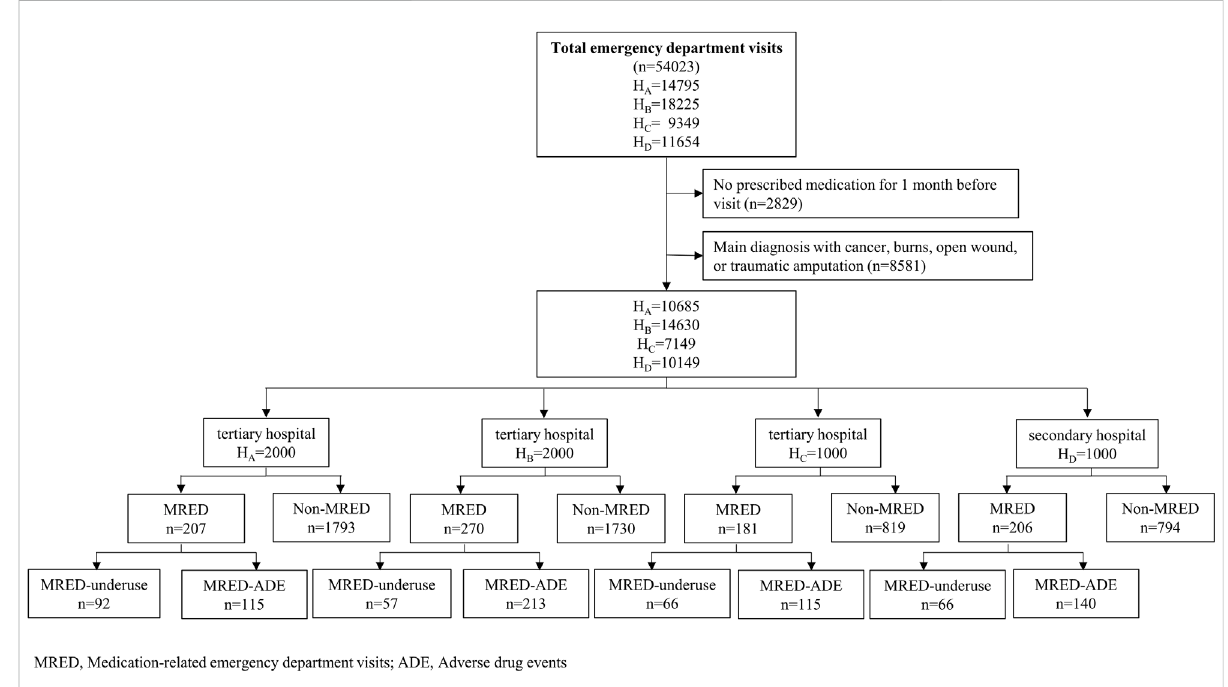
FIGURE 1 Flow diagram of identi fi cation of medication-related emergency department